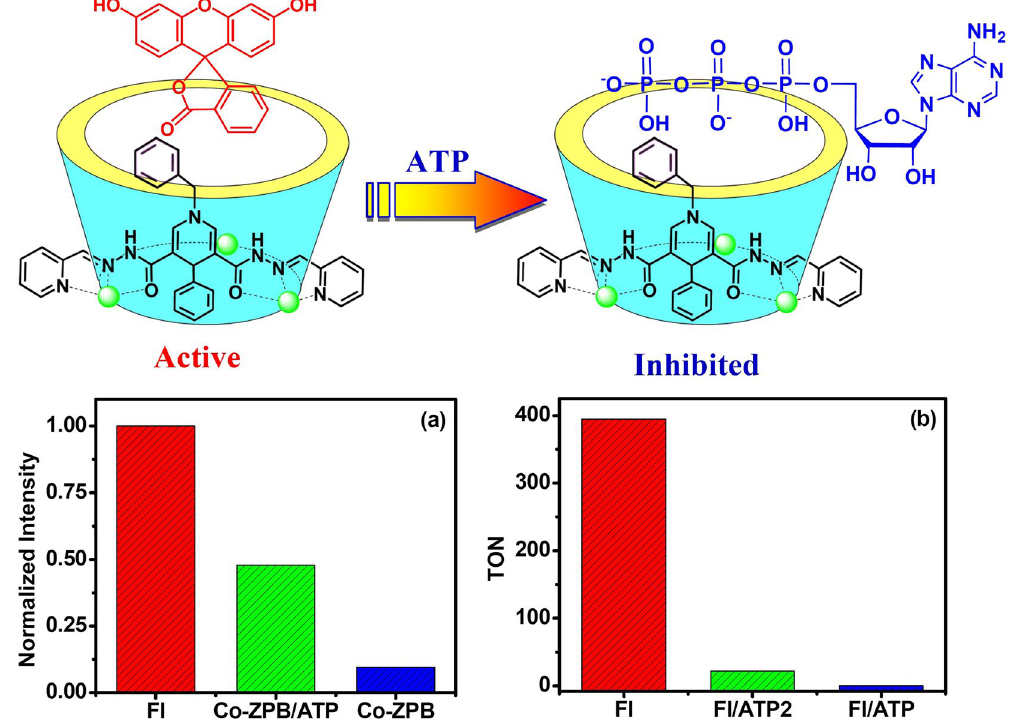
Figure 4. ( a ) Normalized fluorescence of Fl (0.01 mM) (red bar) in CH 3 CN/H 2 O (1:1) at pH 11.0 in the presence of Co– ZPB (0.015 mM) (blue bar) and in the presence of Co– ZPB (0.015 mM) and ATP (0.15 mM) (green bar). The intensities were recorded at 520 nm, with excitation at 460 nm. ( b ) TON of photocatalytic H 2 evolution after 6 hours of irradiation in CH 3 CN/H 2 O (1:1) at pH 11.0 with 5% TEA for the system containing Co– ZPB (0.1 mM)/ Fl (0.1 mM) (red bar) in the presence of 0.2 mM ATP (green bar) or 0.2 mM ATP (blue